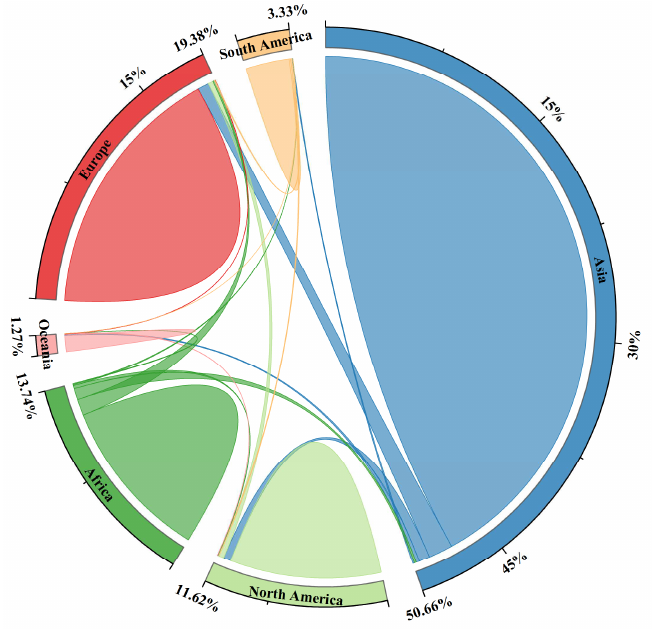
Figure 1. Embodied carbon transfers from trade among six continents (blue represents the carbon outflow of Asia, green represents the carbon outflow of Africa, and the same for other colors). The embodied carbon emissions of the continents from largest to smallest were Asia (52.88%), Europe (22.69%), South America (19.71%), Africa (14.02%), North America (13.08%), and Oceania (1.60%). Asia was most involved in globalization and trades closely with all regions of the world, thus generating the most embodied carbon emissions. With more countries and closer trade, Asia had the most embodied carbon transfers in trade with countries within the continent. Meanwhile, Oceania contained fewer countries and thus had the least embodied carbon transfers with countries within the continent. The embodied carbon transfers in trade within the continents from largest to smallest were Asia (27,547.78 Mt), Europe (10,413.59 Mt), Africa (6619.38 Mt), North America (6130.60